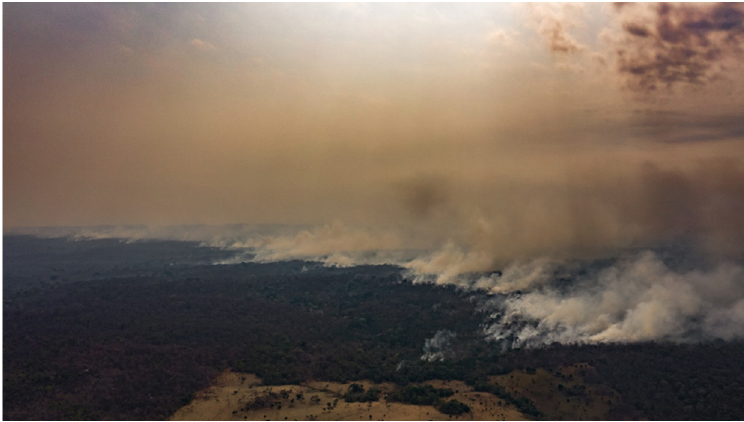
Figure 2. Forest fires in the year 2019, spreading for kilometers in the Chiquitano Forest, area of the municipality of Concepción. Photo: Daniel Coimbra.